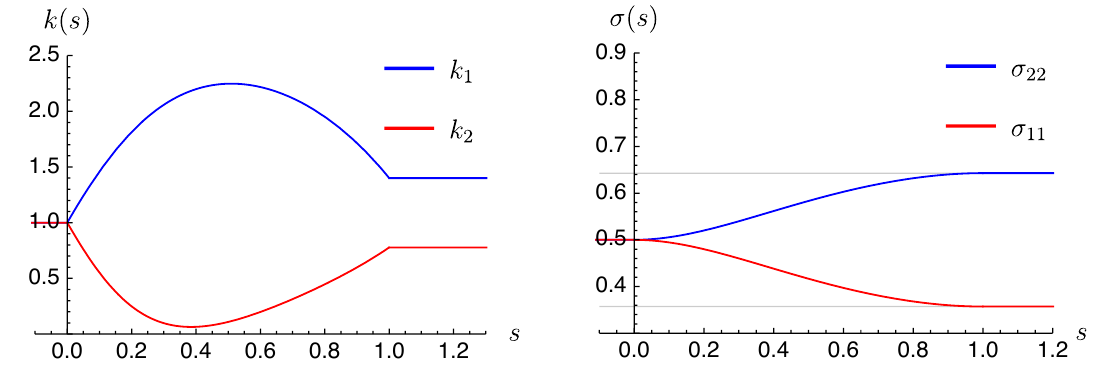
( s ) and k ( s ) computed for the coupled ESE protocol 1 2 = 2.5ms, and Γ = 4.19. While k f